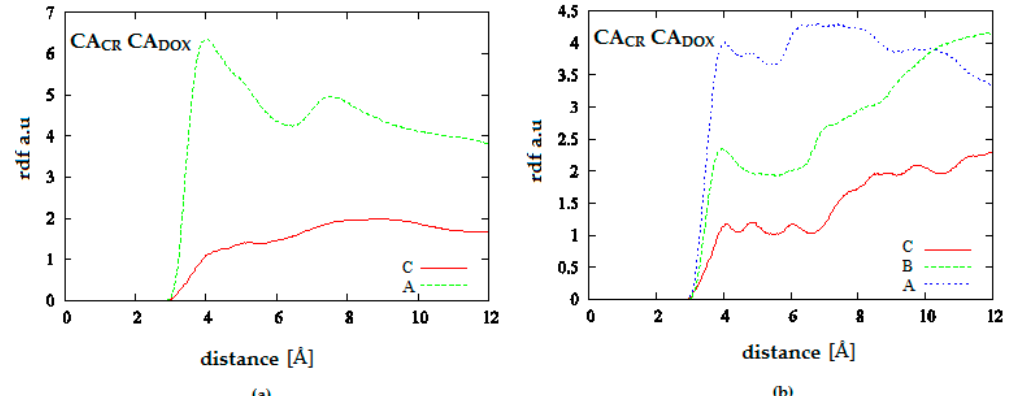
Figure 11. Radial distribution functions for the system: ( a ) SWNT (10.0) complexed with 20 molecules of CR and 10 molecules of DOX; ( b ) SWNT (10.0) complexed with 50 molecules of CR and 20 molecules of DOX; (A—neutral pH, B—medium pH, C—acidic pH). Pharmaceutics 2020 , 12 , x FOR PEER REVIEW